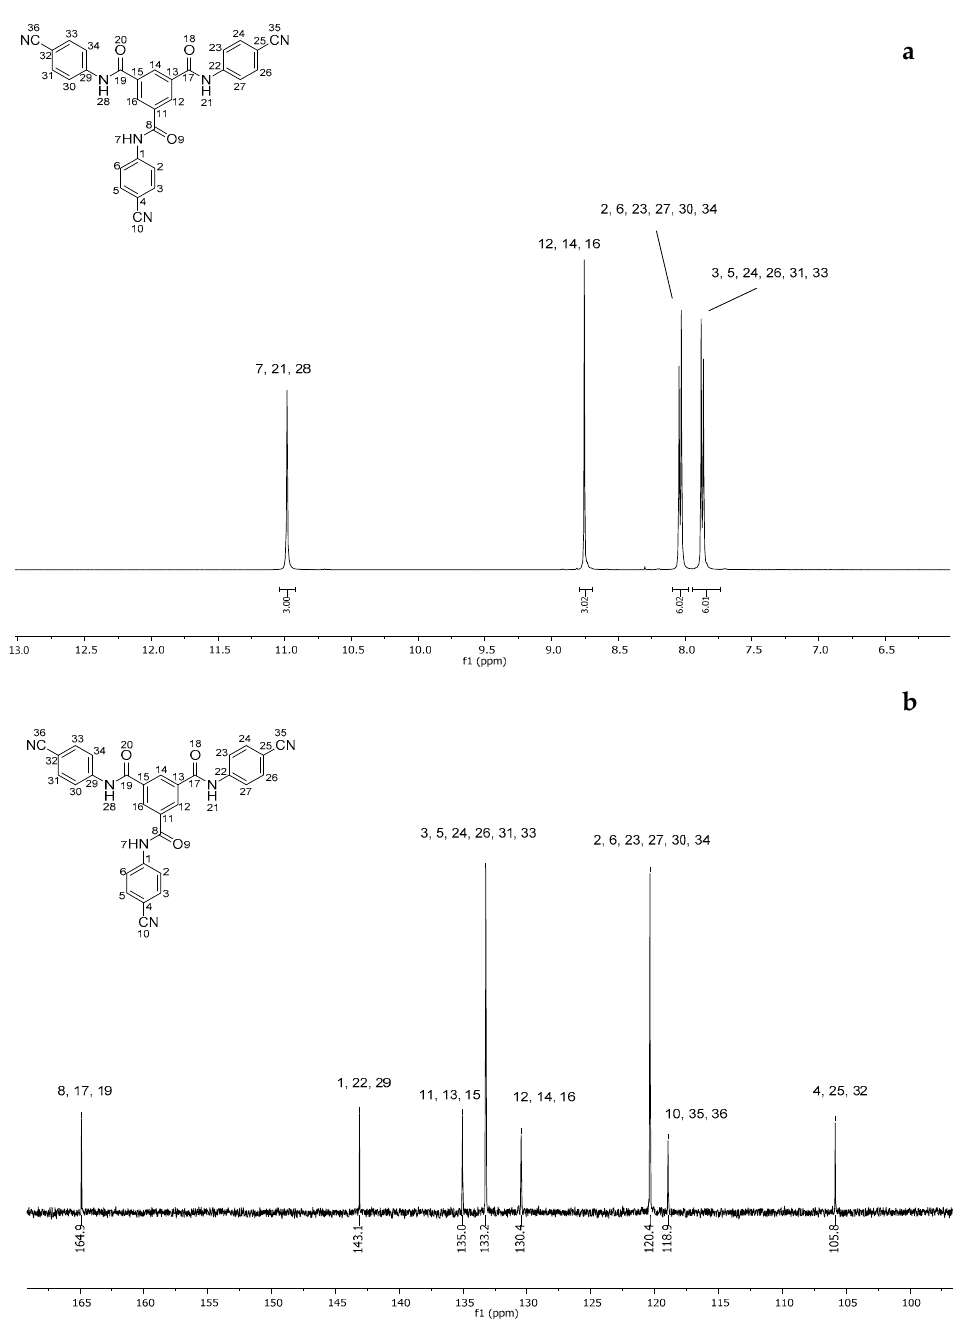
Figure 3 . ( a ) 1 H NMR spectrum and ( b ) 13 C NMR spectrum of intermediate 5 . Figure 3. ( a ) 1 H NMR spectrum and ( b ) 13 C NMR spectrum of intermediate 5